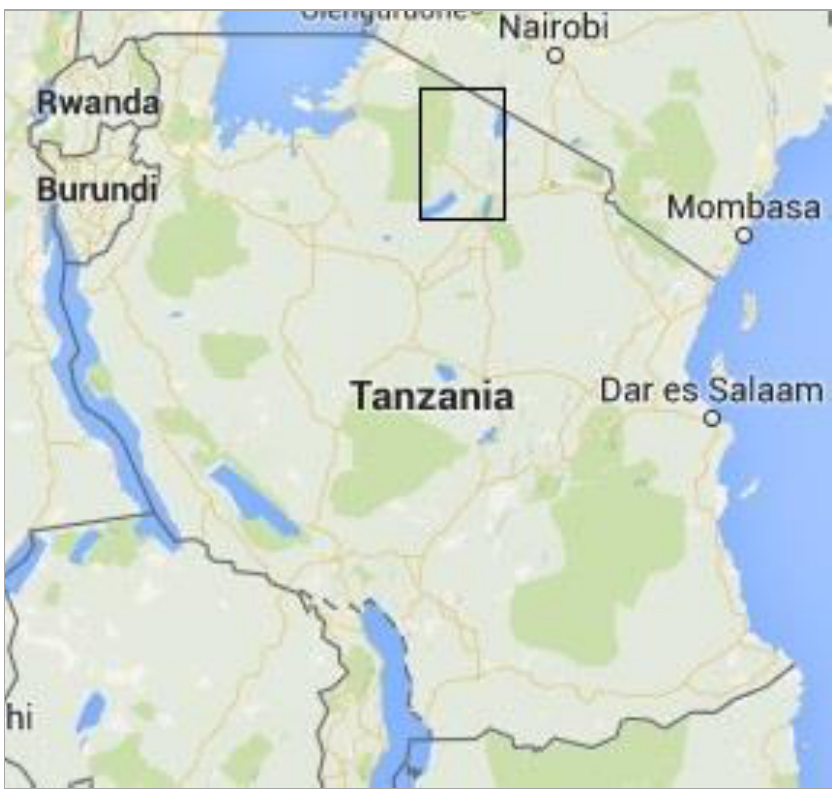
Figure 1. Map of Tanzania. Source: Map data © 2020 Google. The black rectangle indicates the study area in Ngorongoro District in Tanzania, which is shown in more detail in Figure 2. In order to control PPR disease, widespread vaccination against PPRV was carried out in 2011–2012 in northern Tanzania. In Ngorongoro District, it was estimated by the District Veterinary O ffi cer (DVO, third author), based on records of the vaccination campaign, that approximately 70% of the small ruminant population were vaccinated, which led to a reduction in outbreaks. However, the number of cases started to increase again in 2014 and there were many reports of PPR-like disease in the north of the district during the first few months of 2015. In NCAA, where PPR vaccination continued in 2013 and 2014, there were sporadic reports of PPR-like disease. No PPR-like disease had been reported in any wildlife species in any part of the district to the DVO or